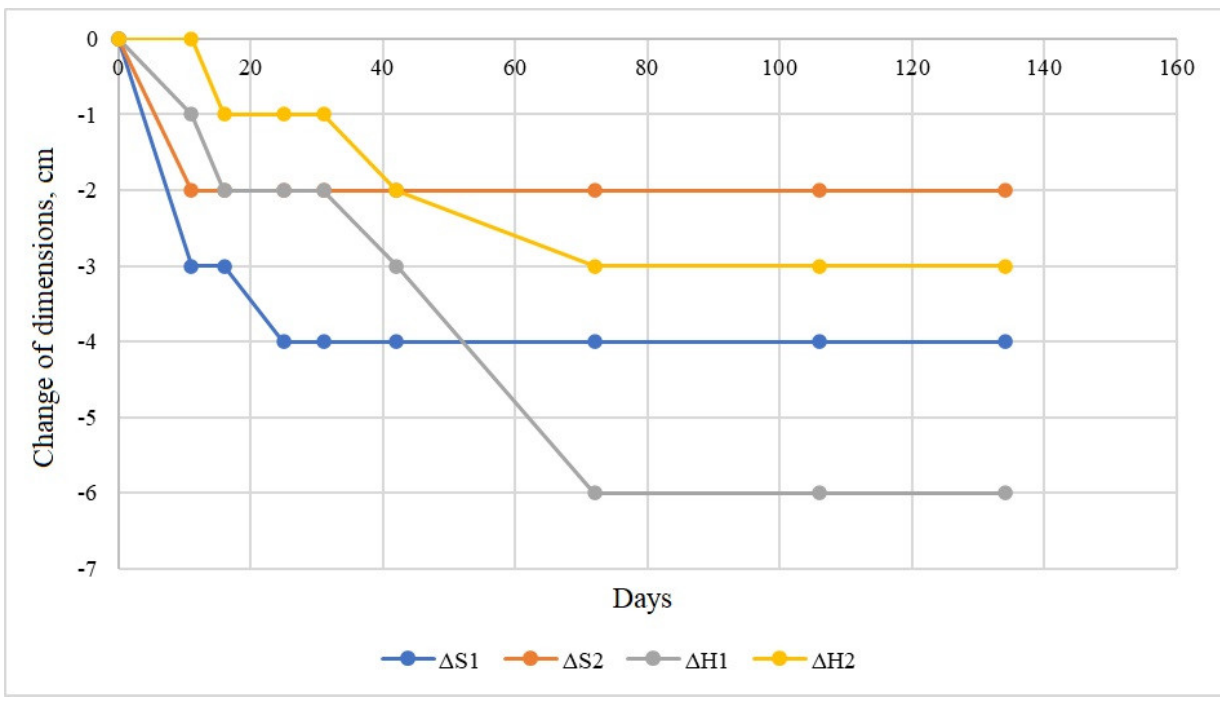
Energies 2022 , 14 , x FOR PEER REVIEW Figure A6. Change of the roadway dimensions—convergence control station no. 2. Figure A6. Change of the roadway dimensions—convergence control station no. 2.